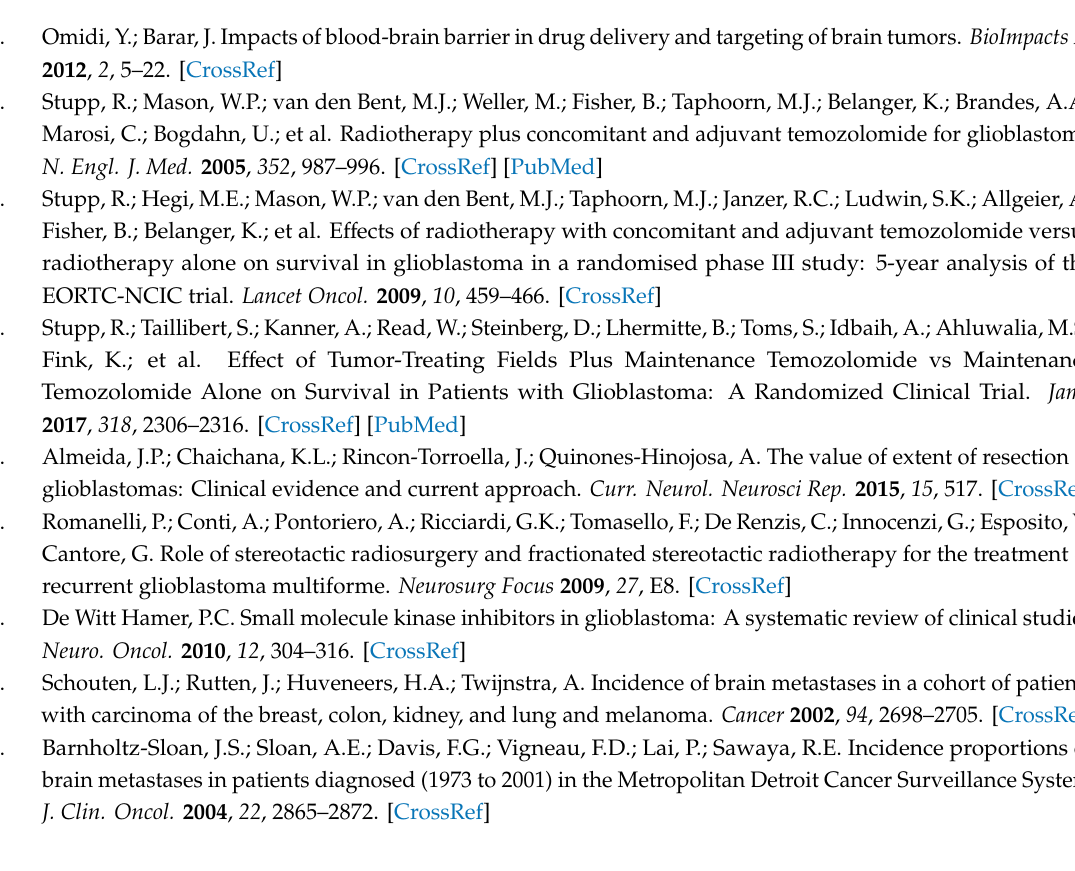
Figure S1: Pooled analysis for intracranial ORR of pembrolizumab in patients with melanoma brain metastases, Figure S2. Pooled analysis for intracranial ORR of nivolumab combined with ipilimumab in patients with melanoma brain metastases, Figure S3. Pooled analysis for ORR of nivolumab in patients with NSCLC brain metastases, Table S1. Full overview of the complete search strategies, Table S2. Studies with immune checkpoint inhibitors in patients with brain metastases that only reported overall survival data, Table S3. Primary outcomes of clinical studies with immune checkpoint inhibitors and radiotherapy in patients with brain metastases, Table S4. Clinical studies with immune checkpoint inhibitors and radiotherapy in patients with brain metastases that only reported overall survival